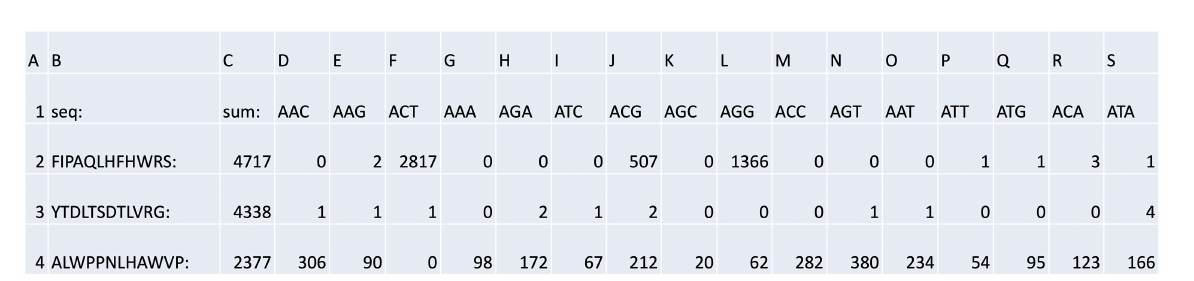
FIGURE 4 Bar code stratification of peptide counts. An example of the peptide sequences enriched against ubiquitin taken from Supplementary Table 2A. The data summarize the top sequences that were detected after next-generation sequencing was applied to the combined phage pools. The data are segregated based on (i) the rounds (1, 2, or 3); (ii) whether short or long washes were used; and (iii) the number of peptide sequences extracted from each bar-coded sequencing pool (The bar-coded data can also be observed in Supplementary Table 2A). The bar codes are in Table